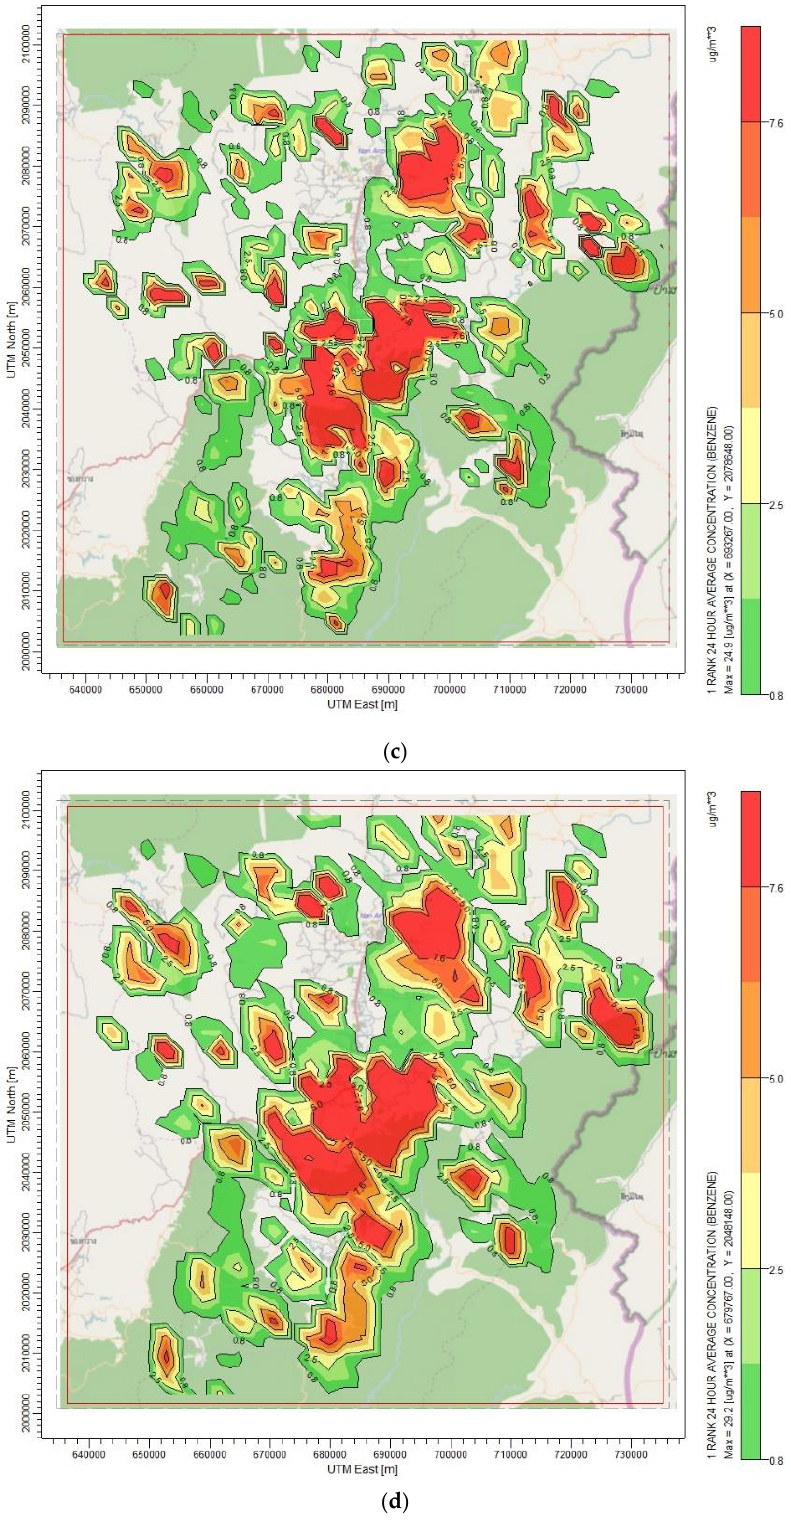
Figure 4. Spatial distributions of 24-h average concentrations of benzene (µg/m 3 ) using different grids resolutions: ( a ) 0.75 km; ( b ) 1 km; ( c ) 2 km; and ( d ) 3 km.